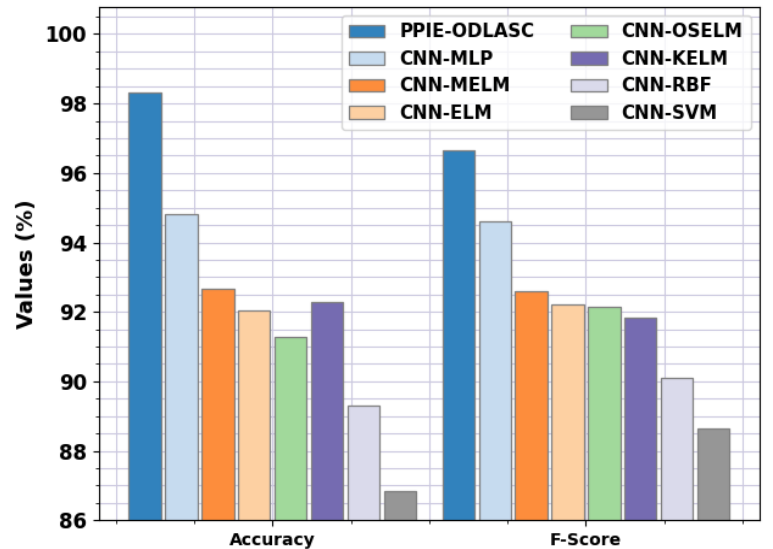
Figure 13. Accu y and F score analysis of the PPIE-ODLASC approach with other recent systems. and analysis of the PPIE-ODLASC approach with other recent systems. Figure 13. Simultaneously, based on F score , the PPIE-ODLASC technique has gained increased 𝐴𝐴𝑐𝑐𝑐𝑐𝑆𝑆 𝑦𝑦 𝐹𝐹 𝑠𝑠𝑐𝑐𝑠𝑠𝑟𝑟𝑠𝑠 F score values of 96.65%, while the CNN-MLP, CNN-MELM, CNN-ELM, CNN-OSELM, CNN-KELM, CNN-RBF, and CNN-SVM models have reported reduced F score values of 94.60%, 92.60%, 92.20%, 92.13%, 91.84%, 90.10%, and 88.66%,